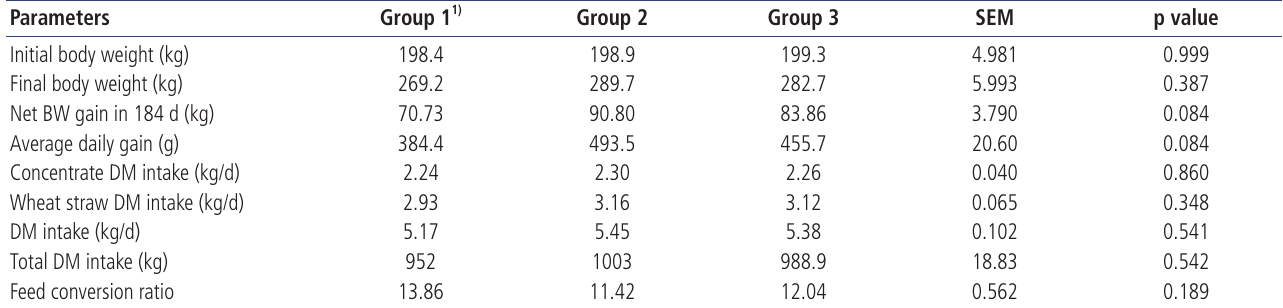
Table 2. Effect of feeding blend of essential oils (BEO) on body weight changes and feed conversion efficiency of growing buffalo calves Parameters